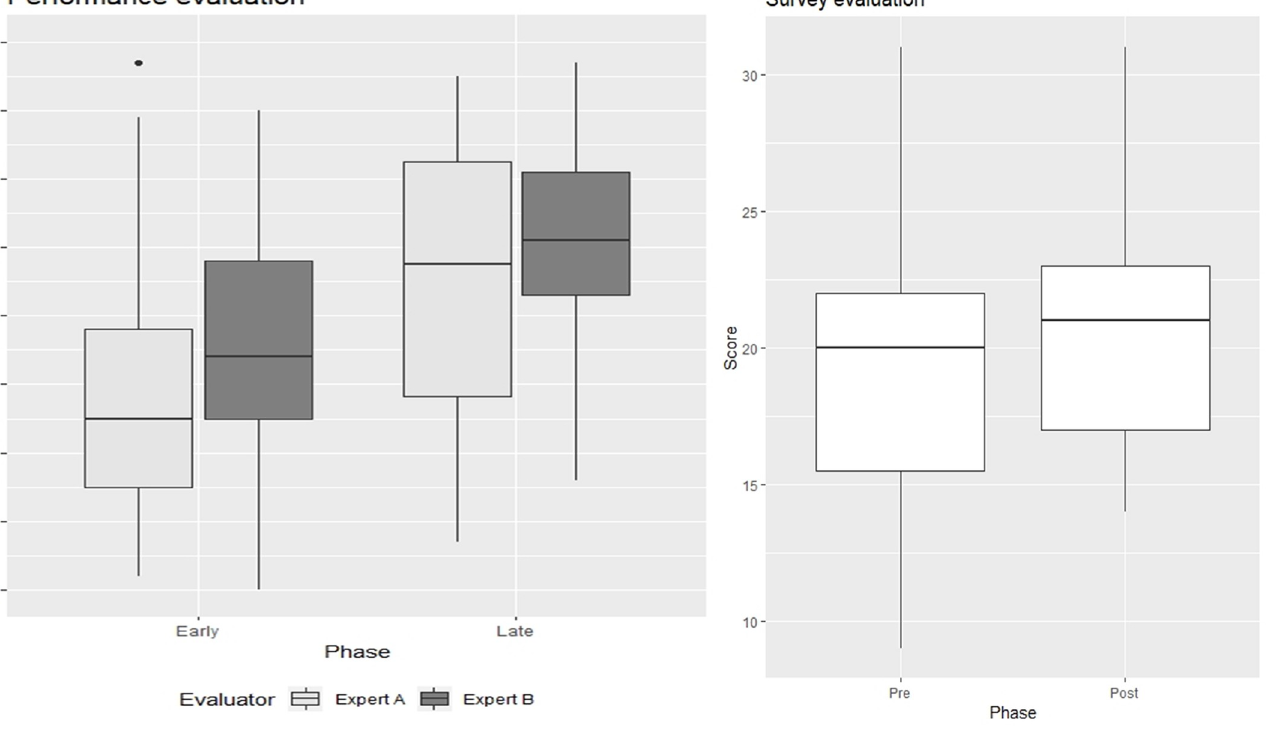
PLOS ONE | https://doi.org/10.1371/journal.pone.0248710 April 2,